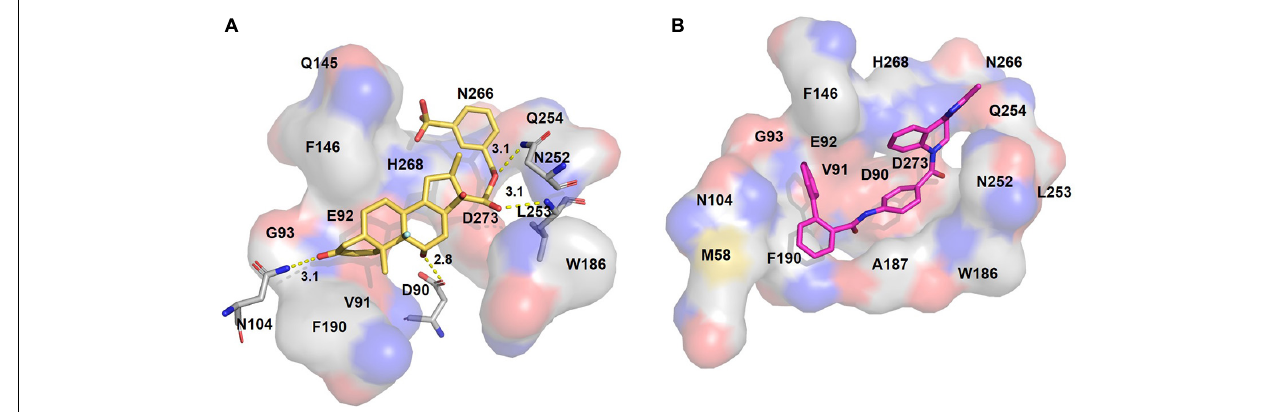
FIGURE 3 | Putative binding pockets of docked compounds. Interaction of ExoN residues (gray) with docked conformer of dexamethasone metasulfobenzoate (yellow sticks) (A) and conivaptan (pink sticks) (B) . H-bonded residues are depicted as sticks. Yellow dotted lines represent hydrogen bond, and the distance is in angstroms (Å). Residues in hydrophobic contact are depicted as surface